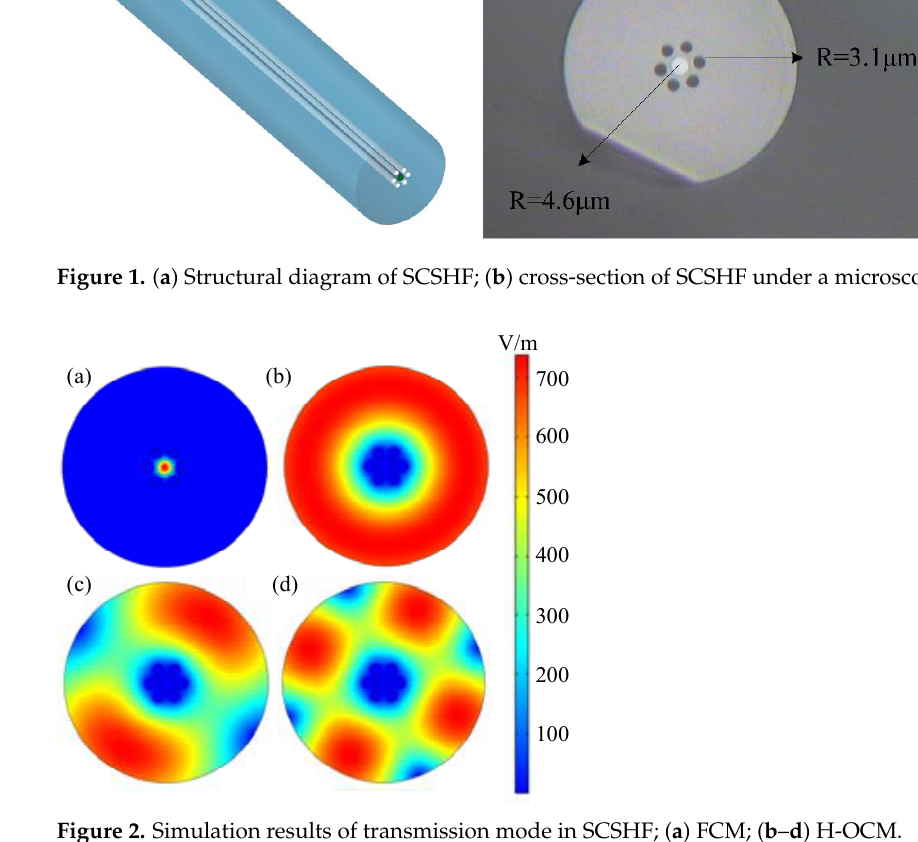
Figure 2. Simulation results of transmission mode in SCSHF; ( a ) FCM; ( b – d ) H-OCM.